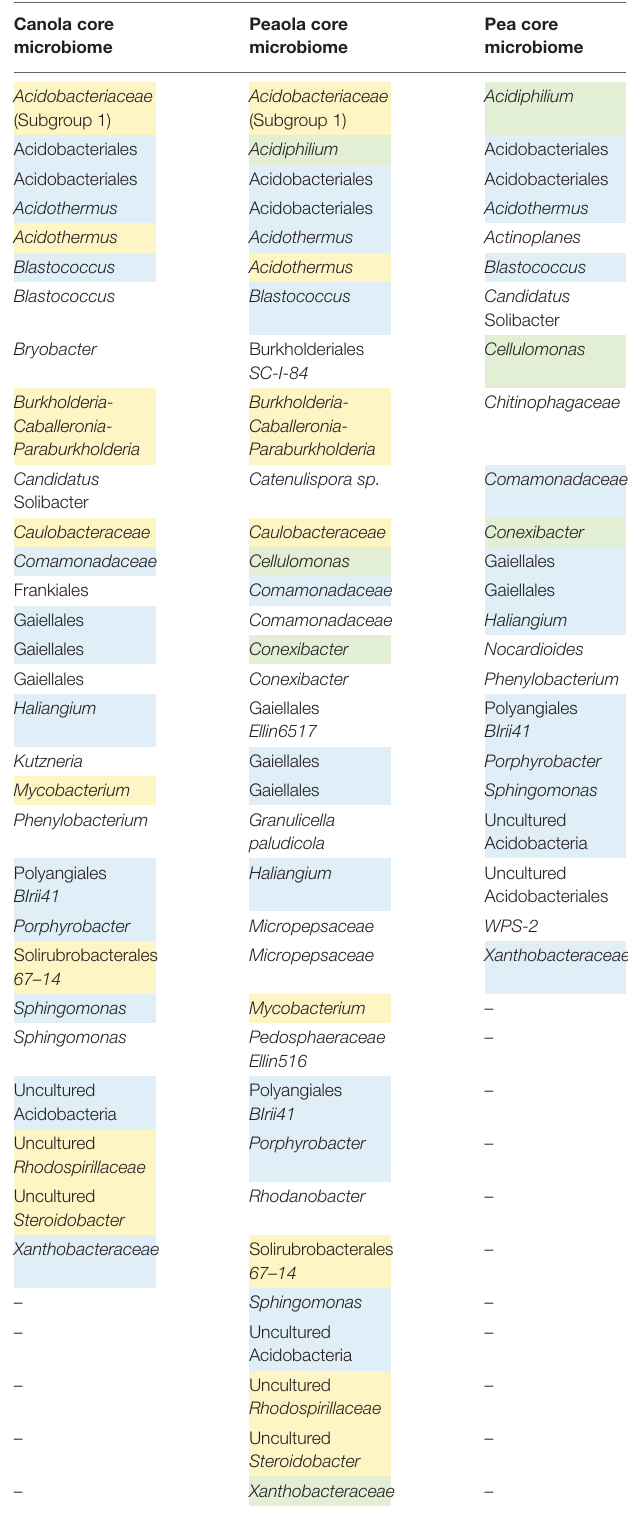
TABLE 3 | Strict bacterial core microbiomes for canola, pea, and